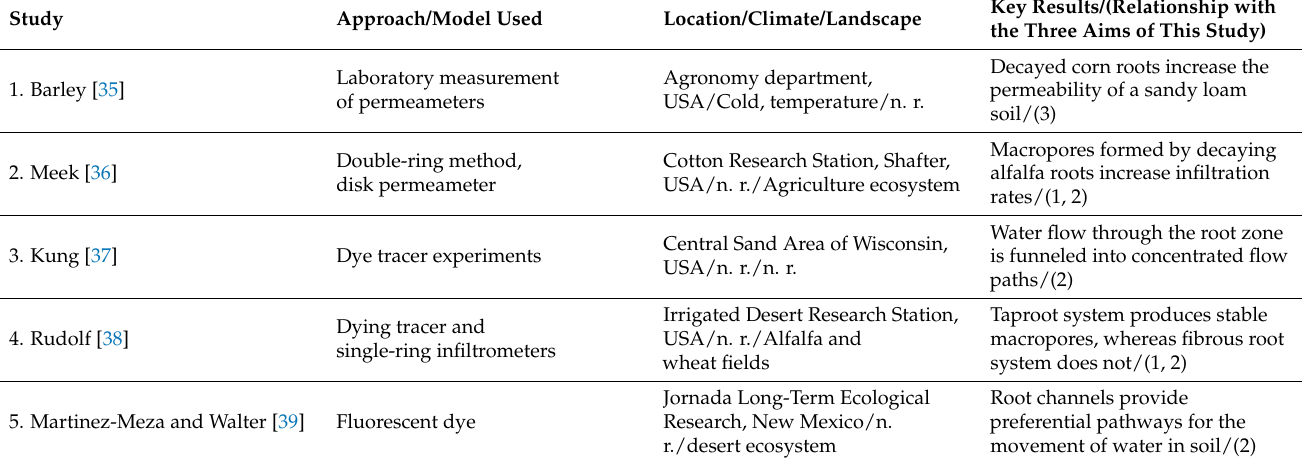
Table 1. Summary of studies relevant to the present work’s objectives to predict the effects of (1) fibrous roots on soil water infiltration in the homogeneous plough layer of an agricultural site; (2) fine roots on soil water infiltration in the hard soil of a forestry site; and (3) smooth roots on soil water infiltration in the multilayered soils of an intertidal zone. We added the current study for completeness. Studies are ordered chronologically and then alphabetically. The symbol “n. r.” means “not